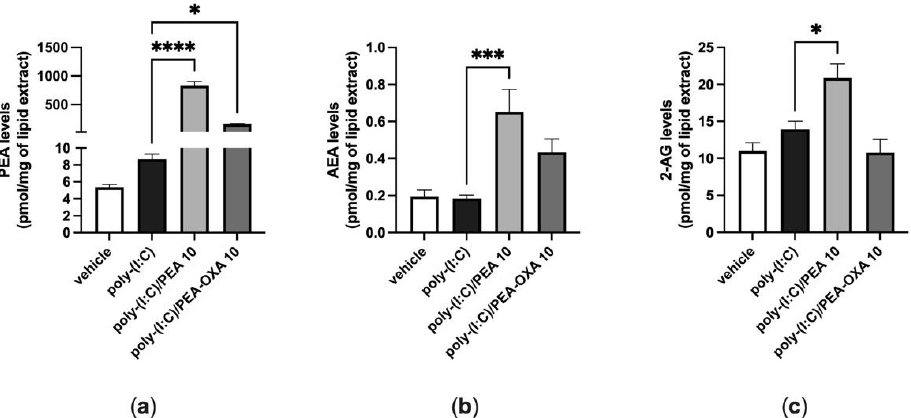
Figure 4. Variation of the levels of PEA, AEA and 2-AG in poly-(I:C)-stimulated A549 cells treated with PEA and PEA-OXA. PEA ( a ), AEA ( b ) and 2-AG ( c ) levels were quantified by LC–MS; after that, A549 cells were stimulated with poly-(I:C) (100 µ g mL − 1 ) in the presence or absence of PEA (10 µ M) and PEA-OXA (10 µ M) for 6 h at 37 ◦ C in a 5% CO 2 atmosphere. Each bar shows the mean ± SEM of independent experiments ( n = 3). The p -values were determined by ANOVA followed by Tukey’s multiple comparisons test. **** p < 0.0001, *** p < 0.001 and * p < 0.05.